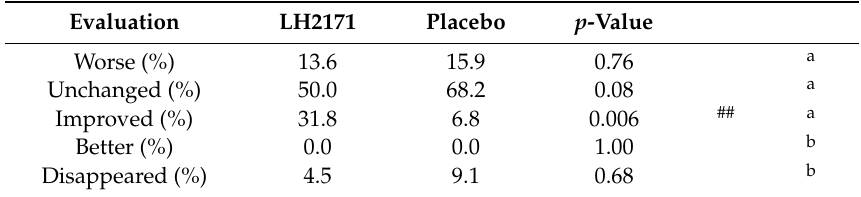
Table 7. Changes in the severity of allergic symptoms from 0 to 16 weeks in the sub-groups with a low friendliness score in POMS 2.